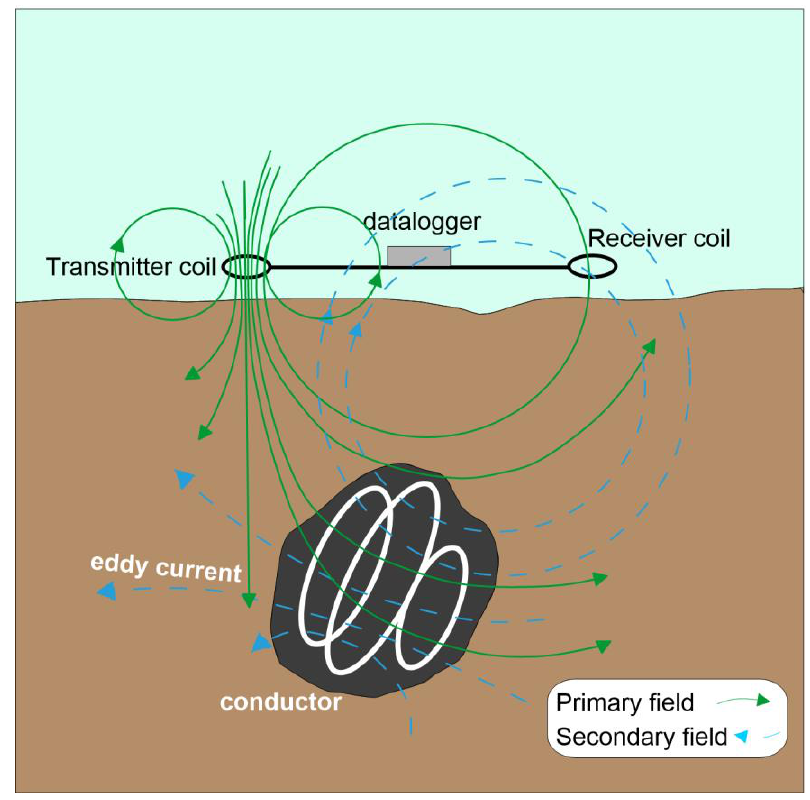
Figure 2. Basics of electromagnetic induction technique.